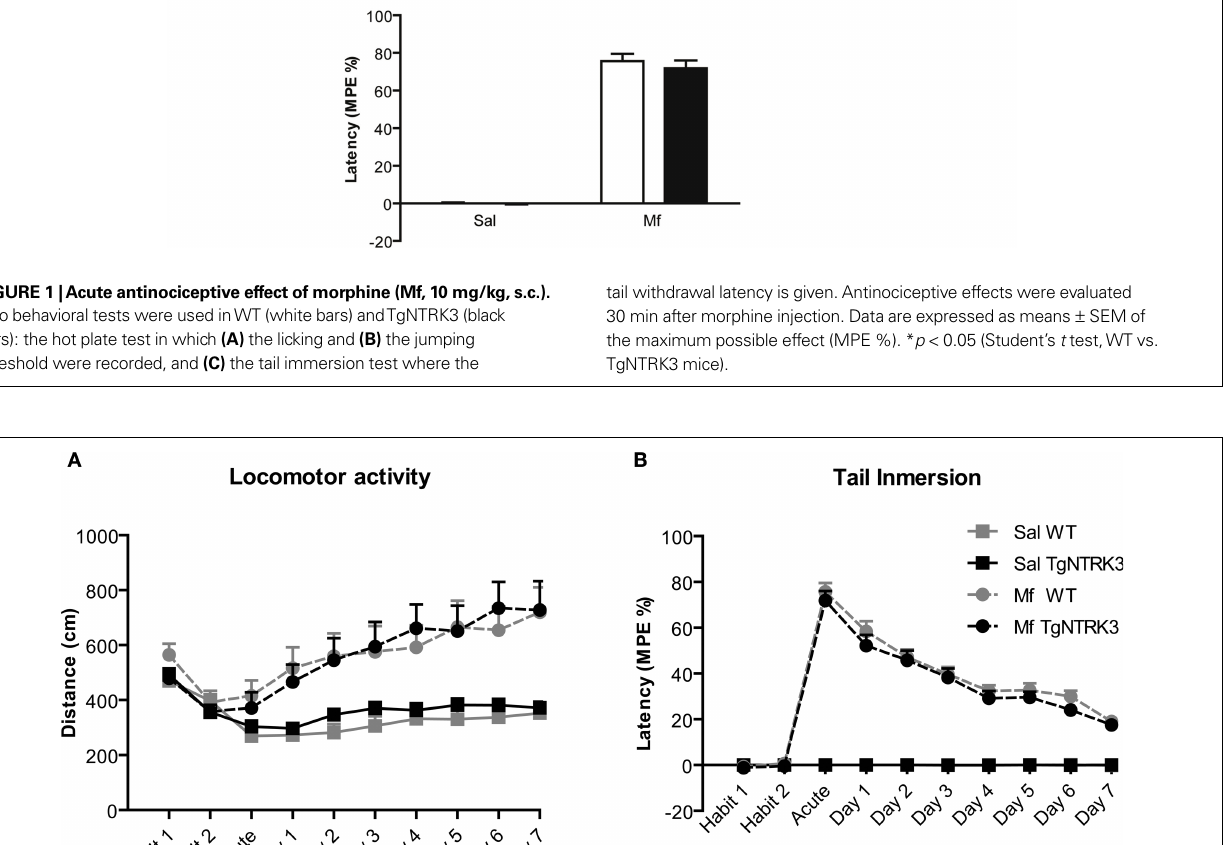
FIGURE 2 | Tolerance to morphine-induced antinociception and sensitization to locomotor effects. Mice received repeated morphine (10 mg/kg, s.c.) or saline injections twice a day for 7 days. (A) Locomotor activity was measured in activity cages during 30 min after the morning injection of morphine during 7 days. (B)